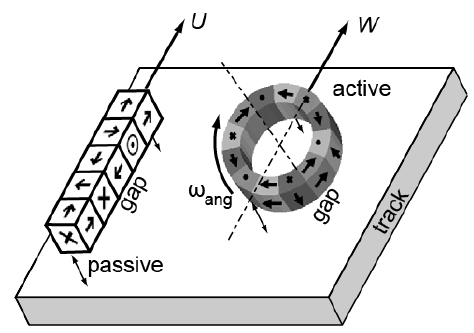
Figure 8. Correspondence of a linear (passive) and a circular (active) arrangement of the Halbach array [19].